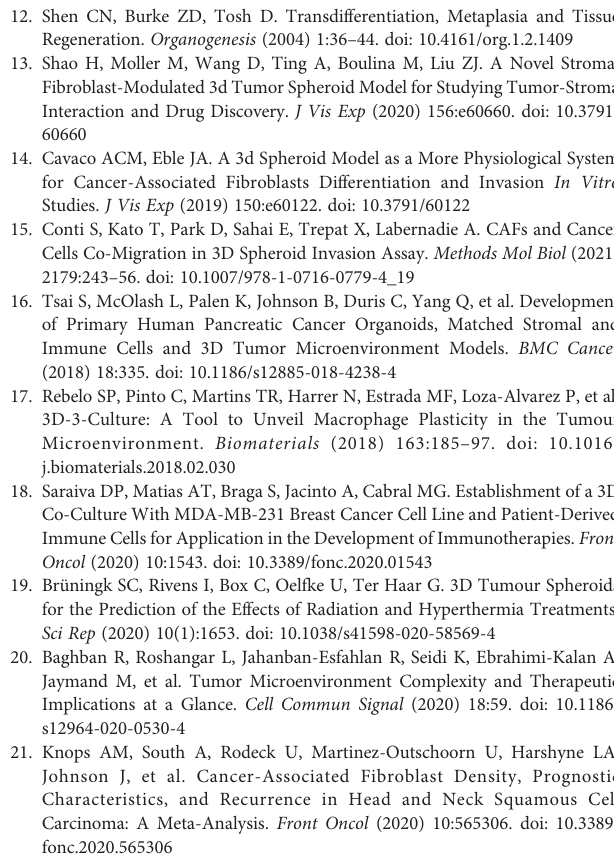
hangingdropmethodanddifferentratiosoftumor/normalcells: fi broblasts:monocytes (1:1:1, 2:2:1, 4:2:1 and5:2:1)were used for proper spheroid development. Supplementary Figure 2 | (A) Microscopic images of BMT, AMT, and HMT spheroids showing spheroid uniformity at day 10. (B) RT-qPCR analysis of N- cadherin gene expression in BMT, AMT, and HMT spheroids on day 7, and day 10. GAPDH was used as loading control. Fold change was calculated keeping the 2D cells at day 0 as control. All experiments were performed in triplicate (n=3). Data represented as mean ± S.D. BMTvs AMT over time ### p< 0.001; BMTvs HMT over time ## p< 0.01, §§§ p< 0.001; ns, non-signi fi cant. Supplementary Figure 3 | (A-B) Percentage of a -SMA+ cells ( fi broblasts) isolated from AMT and HMT spheroids using anti- fi broblast human microbeads. (C, D) Percentage of CD68+ cells (macrophages) isolated from AMT and HMT spheroids using anti-human CD11b microbeads. (E – P) RT-qPCR analysis of MKi- 67 proliferation marker (E, F) , HIF-1 a (G, I) , CA-IX (H, J) , pluripotency markers OCT4 (K, N) , SOX2 (L, O) , and NANOG (M, P) in a -SMA+ cells or CD68+ cells isolated from AMT, and HMT spheroids on day 7, and day 10. Fold change was calculated keeping MRC5 or THP-1 as control cells/day 0. All experiments were performed in triplicates (n=3). Data represent as mean ± S.D. *p< 0.05, **p< 0.01, ***p< 0.001; ns, non-signi fi cant. Supplementary Figure 4 | (A – B) . Images representing H&E staining of non- cancerous normal lung tissue biopsies and cancerous lung adenocarcinoma biopsies. (A, C) . RT-qPCR analysis showing a -SMA (C) , and FSP1 (D) gene expression in normal lung tissue biopsies (non-cancerous, n=5) and lung adenocarcinoma tissue biopsies (cancerous, n=5). (E, F) . RT-qPCR analysis showing CD163 (E) , and CD206 (F) gene expression in normal lung tissue biopsies (non-cancerous, n=5), and lung adenocarcinoma tissue biopsies (cancerous,